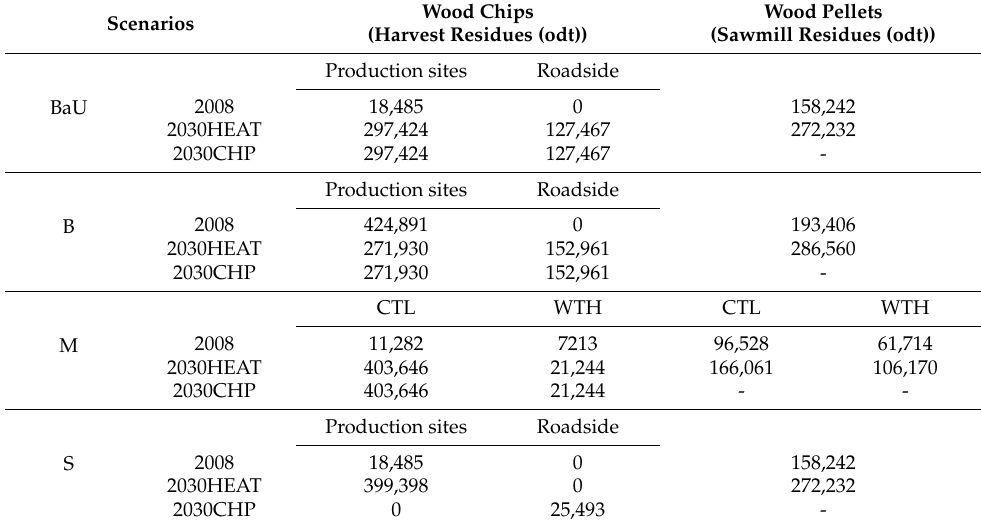
Table 3. Scenario